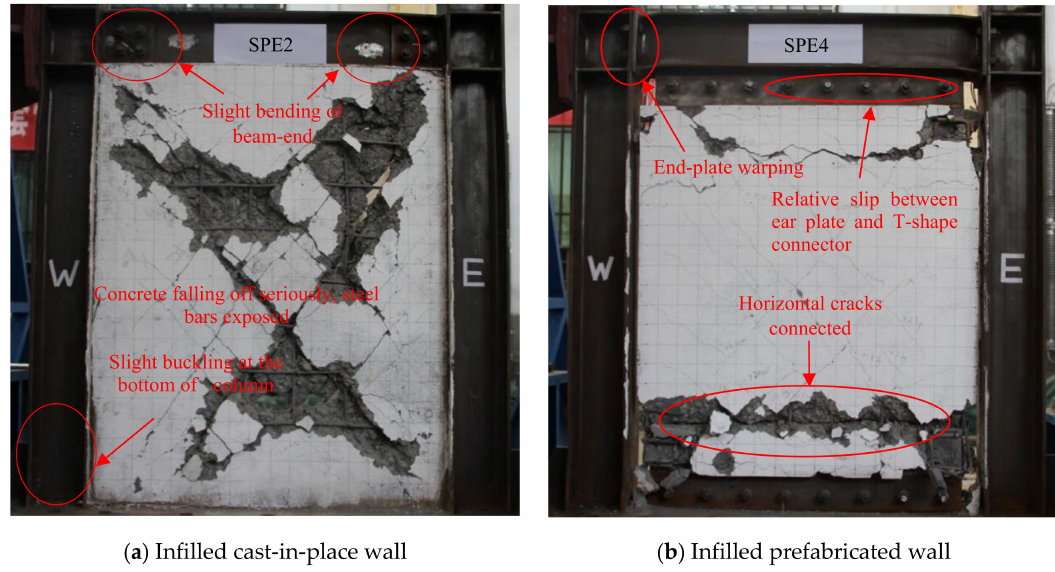
Figure 9. Failure